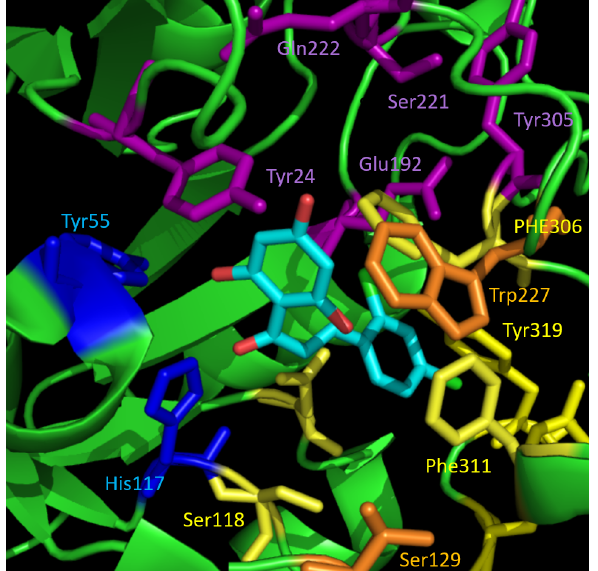
Figure 5. Binding pocket of AKR1C3 with the docking pose of active compound 23 (cyan). The interaction partners of the catalytic tetrad are shown in blue. The residues forming the three different subpockets SP1–3 are highlighted in different colours: SP1—yellow, SP2—orange, SP3—violet. The chalcone scaffold binds to catalytic amino acids and SP1 .